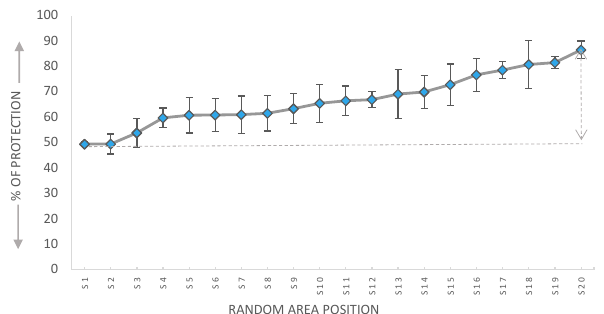
Figure 10. Sensitivity of SOILCONSWEB-GCI with respect to the index ( d s ) of soil protection towards groundwater pollution (% of protection on y axes). On the x axes we gave 20 different locations of the AOI (positioned randomly in the main agricultural areas of Valle Telesina). The AOI was kept constant in terms of its the shape and surface (57ha). Data were plotted ranked on the base of the mean index of soil protection towards